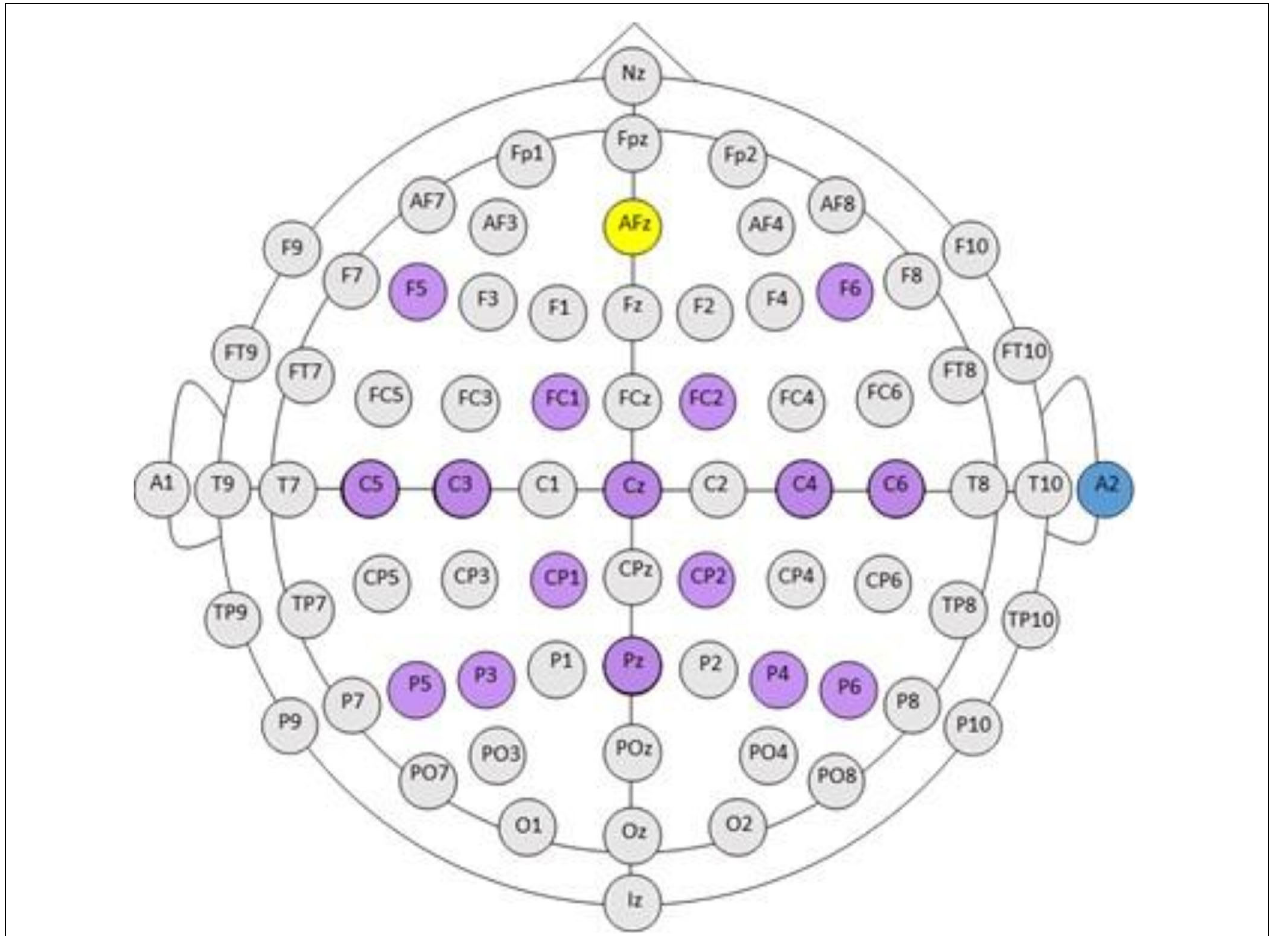
FIGURE 1 | BCI cap array. International 10–20 system for standardized EEG electrode locations on the head: C, central; P, parietal; T, temporal; F, frontal; Fp, pre-frontal; O, occipital. Electrode array and cap arrangement for all n = 16 participants is indicated in purple against the standard 10–20 electrode array head map. AFz (yellow) is the ground electrode. A2 (blue) electrode is the reference electrode, placed on the back of the right ear. Please note, electrode arrangement is designed for increased density around cortical sensorimotor